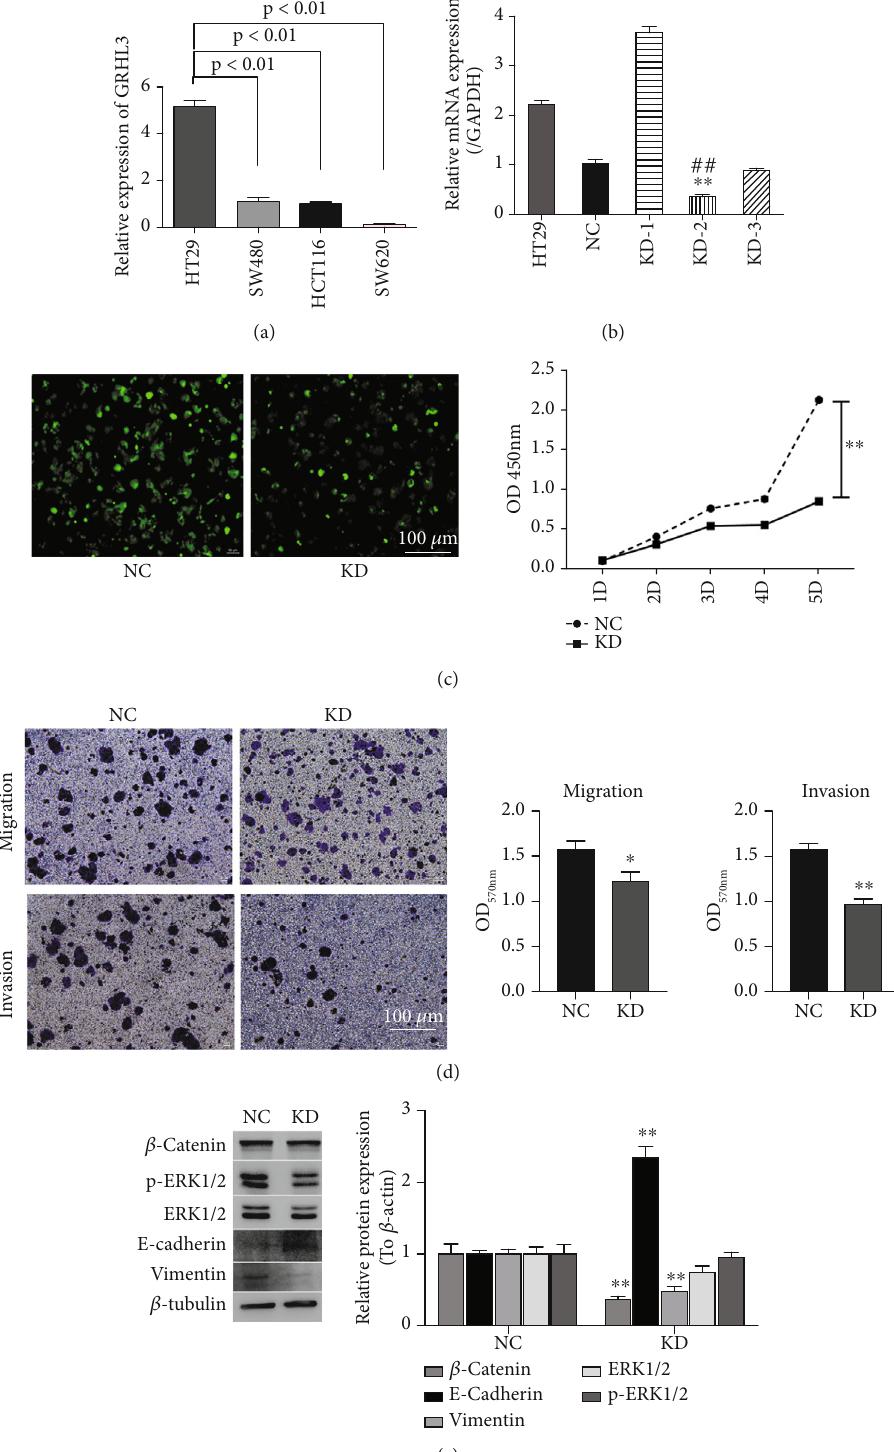
Figure 3: Knockdown of GRHL3 inhibits EMT mediated by the MAPK/ERK pathway. (a) qPCR results showed the mRNA level of GRHL3 in HT29, SW480, HCT116, and SW620 cell lines. The data are presented as mean ± SEM ( n = 3 ). (b) HT29 cells were transfected with three shRNA targets GRHL3 (KD-1, KD-2, and KD-3) or a scrambled sequence. The interference e ffi ciency of GRHL3 expression was measured using qPCR. ∗∗ P < 0 : 01 vs. negative control (NC). (c) In vitro cell growth of HT29 stably transfected cells was examined by the cell proliferation assay. ∗∗ P < 0 : 01 compared with cells transfected with NC. (d) Cell migration was detected by transwell in two stable cells. (e) Protein expression of β -catenin, p-ERK1/2, ERK1/2, E-cadherin, and Vimentin was detected using western blotting, and β -tubulin served as a loading